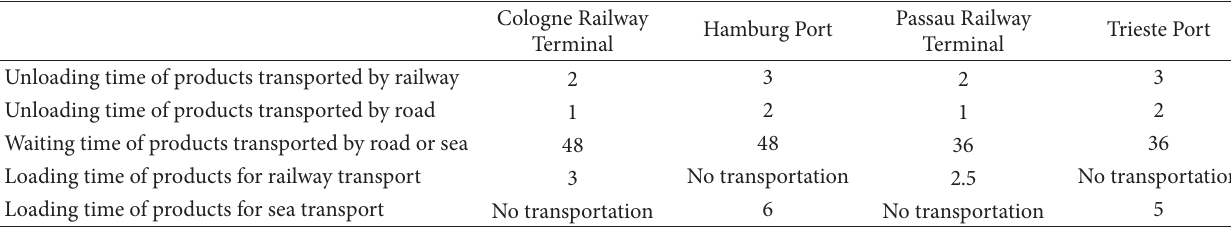
Table 11: Unloading, warehousing, and loading times in the first transshipment terminals